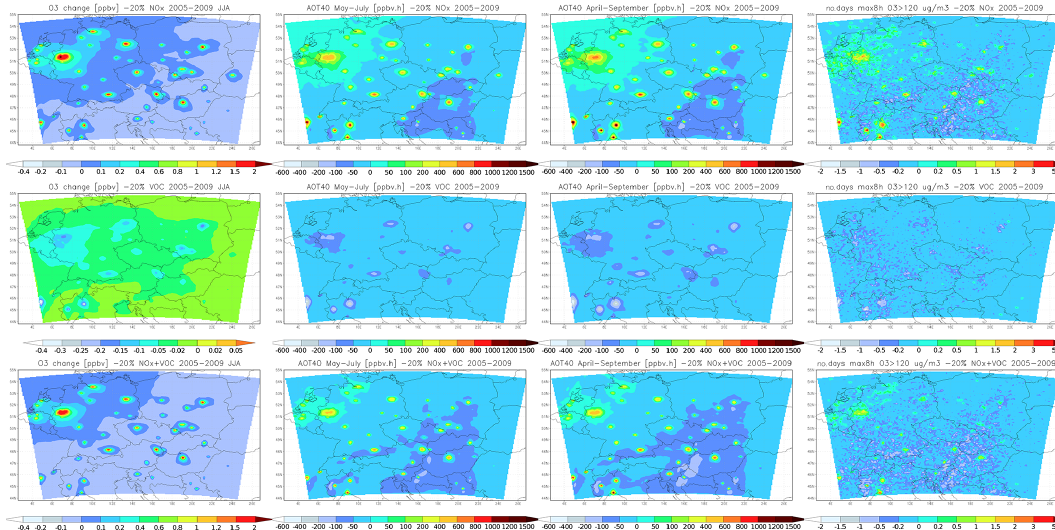
Figure 11. Impact of 20% reduction of NO x (upper row), 20% reduction of NMVOC (middle row) and 20% reduction of both NO x and NMVOC (bottom row) on ozone related air quality measures: average JJA ozone, AOT40 for crops and forest, and, the average number of days with maximum 8h ozone running mean greater than 120µgm − 3